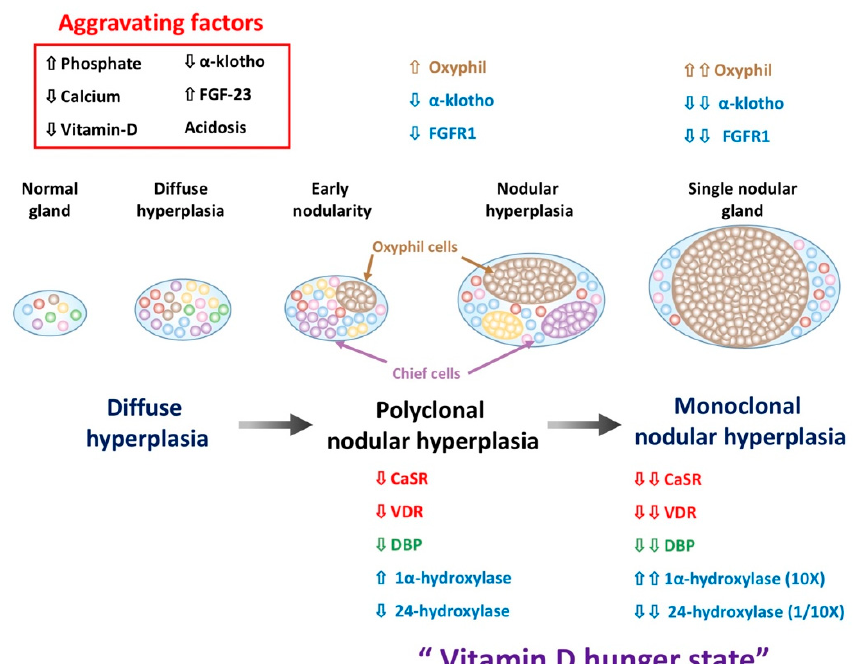
Figure 1. The development of parathyroid gland hyperplasia in secondary hyperparathyroidism (SHPT). In advanced SHPT, monoclonal cell growth vigorously that occupy the most of the gland and form a single large nodule. Both α -klotho and FGFR1 expression on parathyroid cells are decreased during the progress of hyperplasia and are negatively correlated with the volume of the hyperplastic parathyroid tissue. The reduced VDR and CaSR expression is prone to nodular hyperplasia and is considered to be in a relation to calcitriol or calcimimetics resistant. Increased 1 α -hydroxylase and decreased 24-hydroxylase expression in secondary hyperplasia PTG cells would highlight the requirement of more 25D in SHPT. In parathyroid cell, the translocation of vitamin D from cytosol into mitochondria for 1,25D synthesis with the help of cytosolic DBP, and reducing the cytosolic DBP content within oxyphilic cell predominant parathyroid nodules might decrease the amount of local intracellular 1,25D production. This hydroxylase enzyme and cytosolic DBP change highlight the requirement of more 25D in SHPT, called vitamin D hunger. Increasing the serum level of 25D increases the intra-parathyroid free and bound 25D levels, which might overcome the decreased DBP levels, and improve the vitamin D hypo-responsiveness state in PTG among SHPT patients.(Abbreviation: SHPT, secondary hyperparathyroidism; FGFR1, fibroblast growth factor receptor 1; VDR, vitamin D receptor; CaSR, calcium sensing receptor; 1,25D, 1,25-dihydroxy vitamin D; PTH, parathyroid hormone; PTG, parathyroid gland; VDD, vitamin D deficiency, DBP: vitamin D binding protein; 25D, 25-hydroxy vitamin D.).